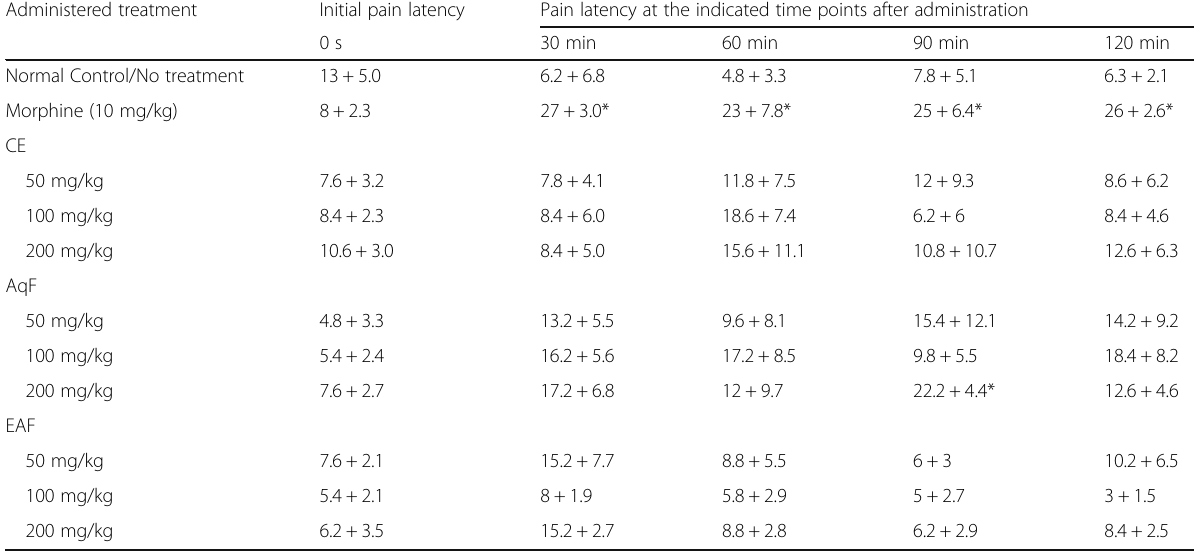
Table 3 Evaluation of the analgesic activity of E. uniflora CE and fractions at various doses Administered treatment